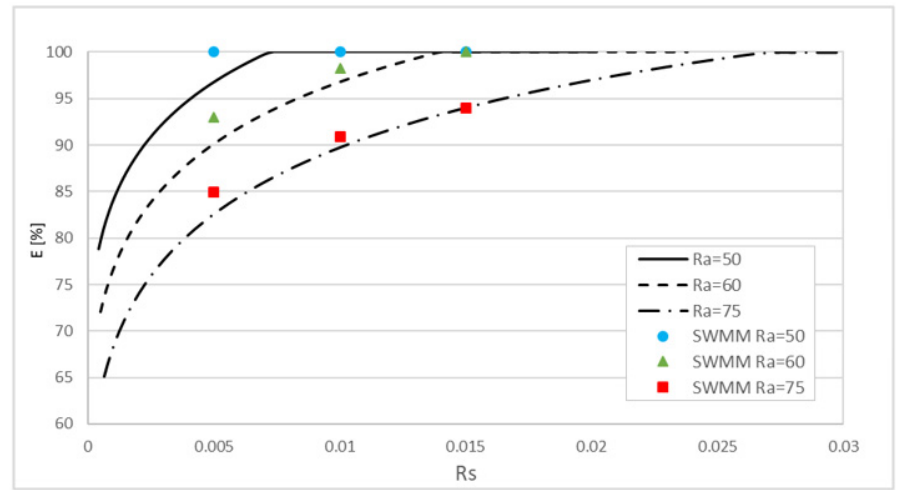
Figure 4. Efficiency as a function of shape factor for three different trench surfaces Ra : 50, 60 and 75. Symbols represent efficiency evaluated with the LID module of SWMM.